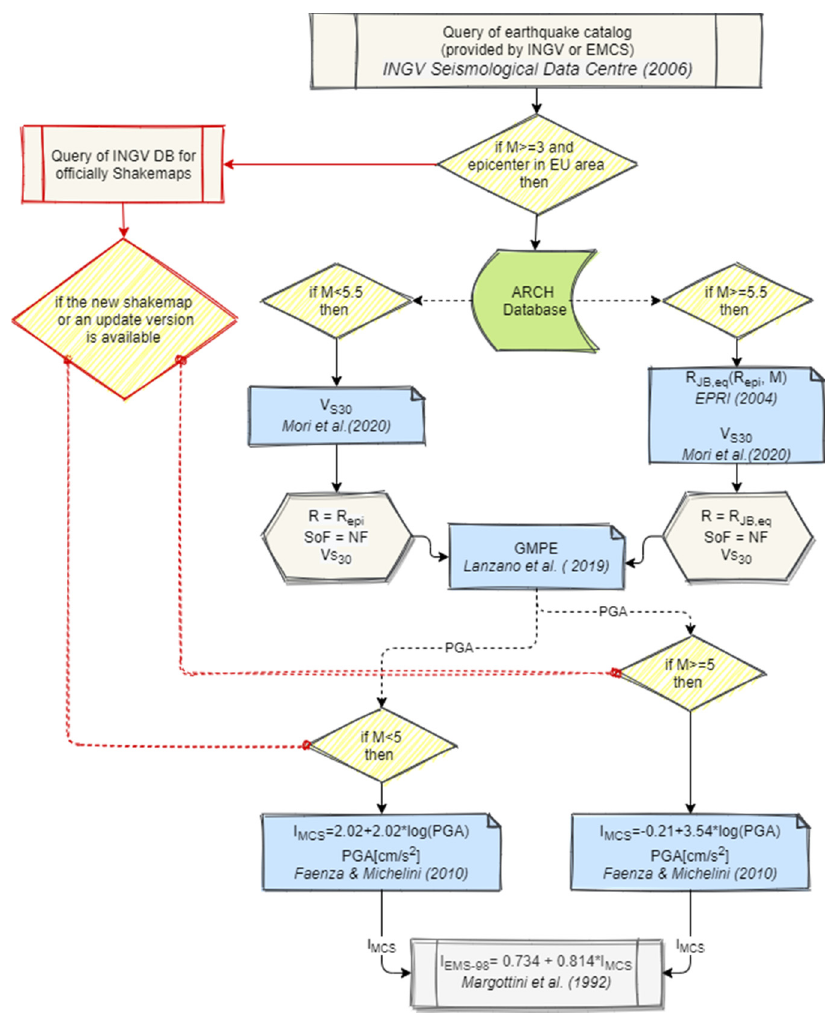
Figure 4. Workflow of ARCH DSS hazard assessment module: assessment of deterministic ground shaking maps in peak ground acceleration (PGA) using GMPE by [53] and PGA to I MCS and I EMS98 conversion [54] .